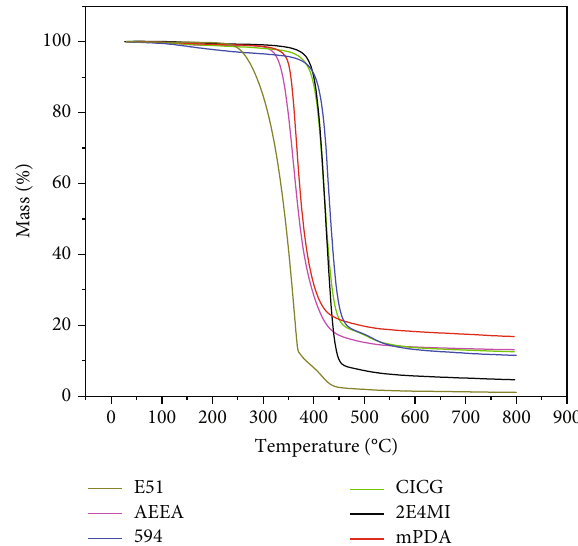
Figure 2: Thermogravimetric (TG) curves of the EP matrixes. The initial thermal decomposition temperatures of E51 EP, AEEA EP, 594 EP, CICG EP, 2E4MI EP, and mPDA EP were 231.0 ° C, 336.2 ° C, 368.4 ° C, 400.5 ° C, 403.7 ° C, and 352.2 ° C, respectively. The ending thermal decomposition temperatures of E51 EP, AEEA EP, 594 EP, CICG EP, 2E4MI EP, and mPDA EP were 459.95 ° C, 394.5 ° C, 490.3 ° C, 441.3 ° C, 440.5 ° C, and 392.9 ° C, respectively.